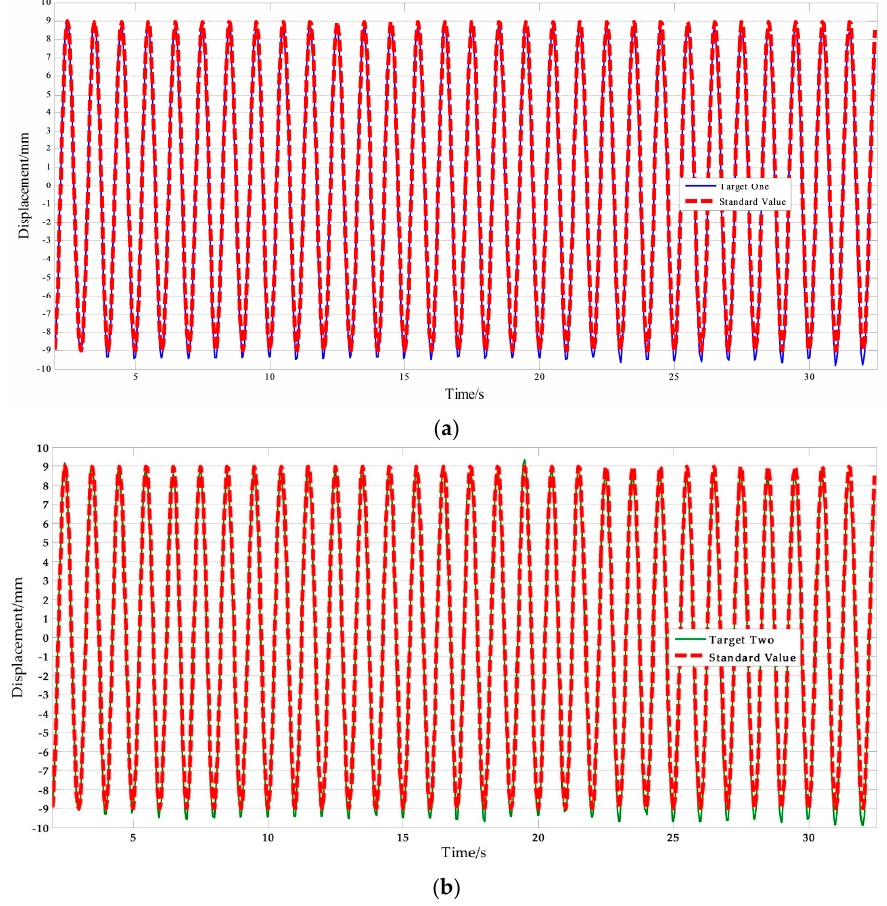
Figure 14. Free target measurement results of vision sensor capturing ( a ) Target one; ( b ) Target two. ( f = 1.0 Hz, A = 9 mm) Table 11. NRMSE analysis of free target experimental results with higher frequency.